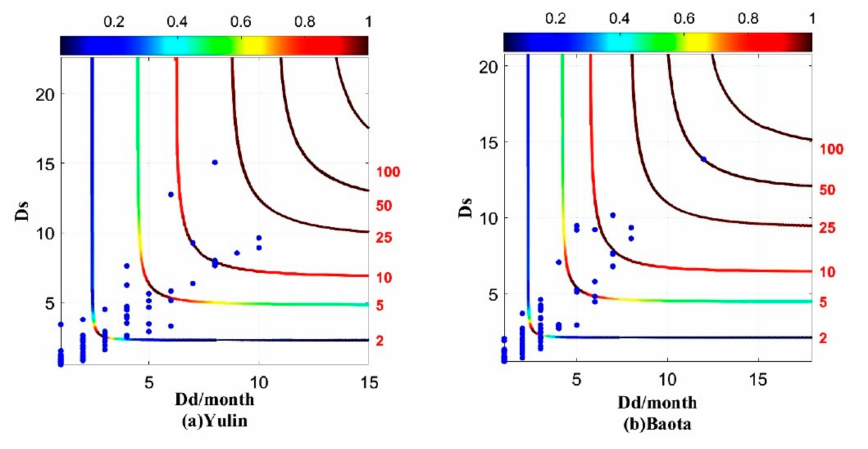
Figure 6. Joint return period contour